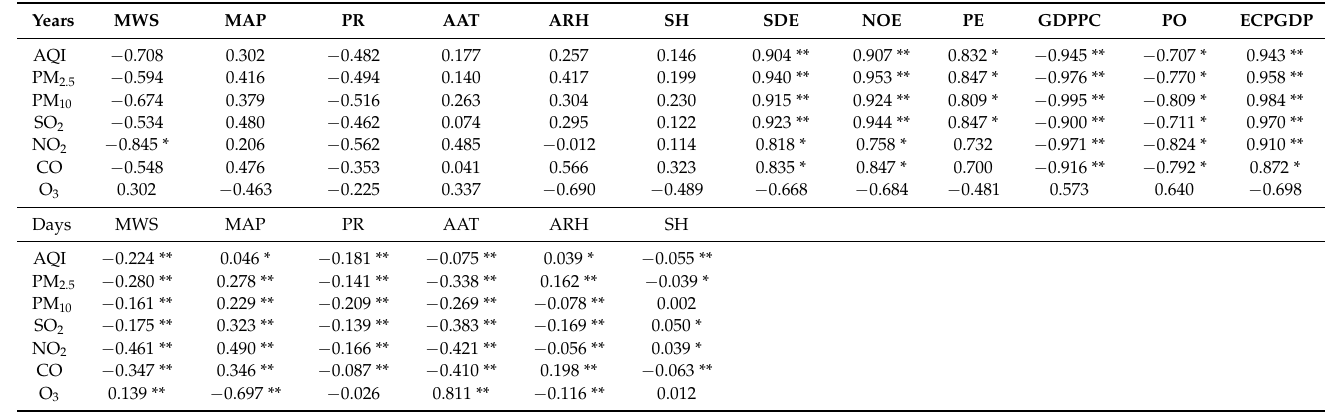
Table 2. Relevant coefficients (R) between air quality, meteorological factors, air pollution emissions, GDPPC, population, and ECPGDP.